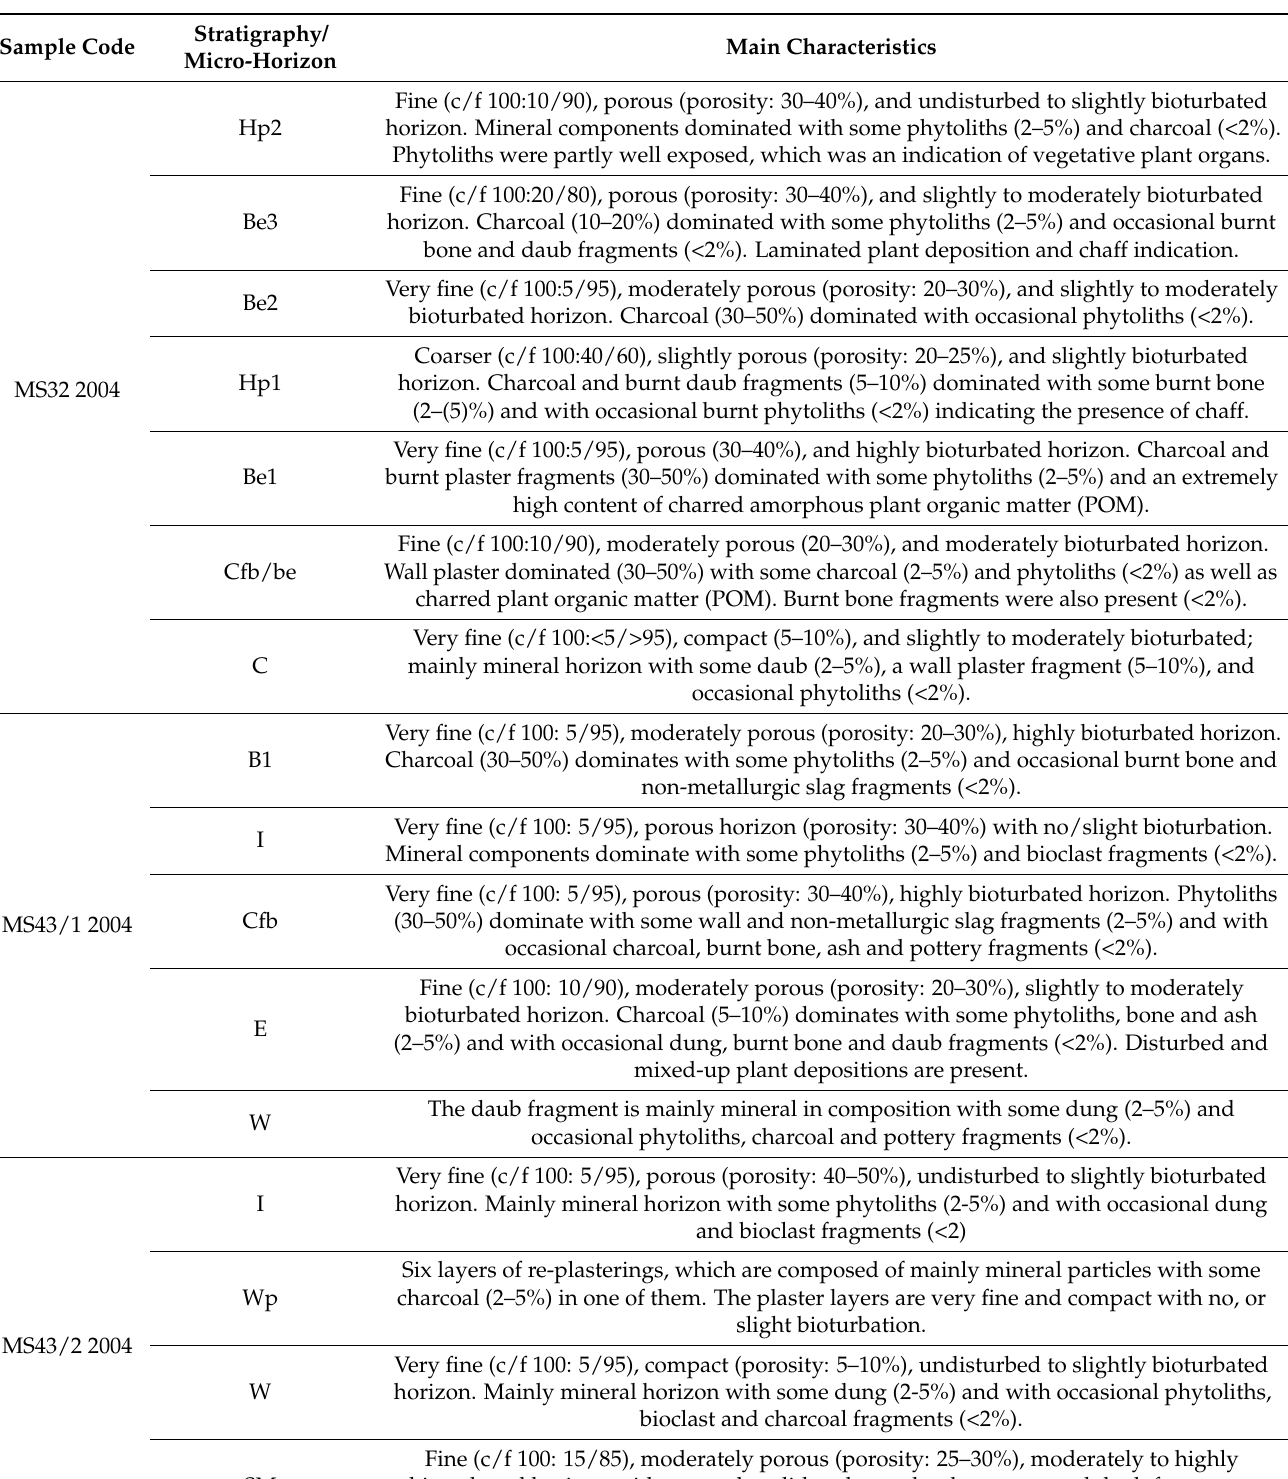
Table 2. Characteristics of the examined